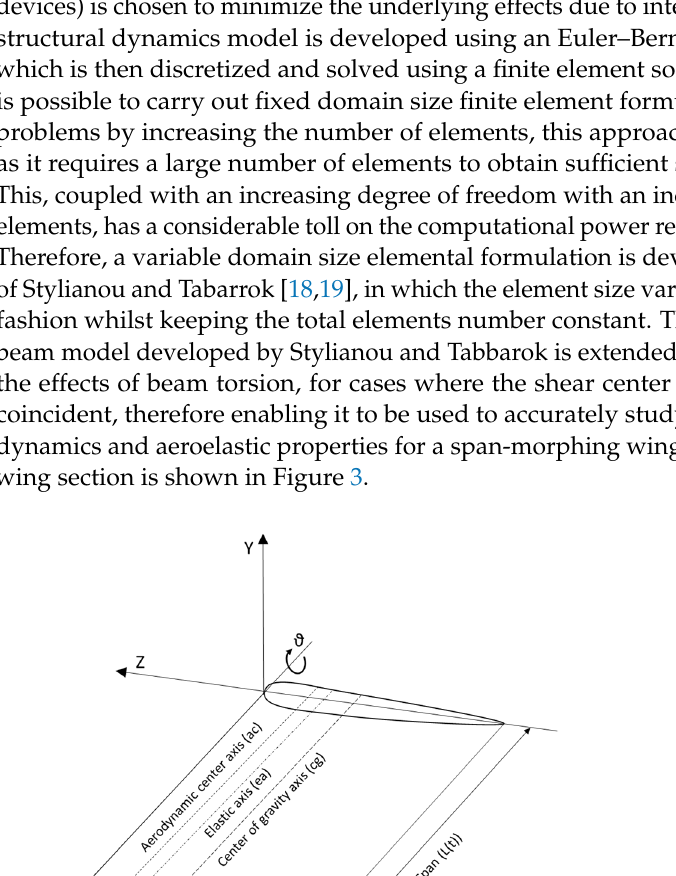
Figure 2. ASAPP wing internal structure ( left ) and actuation mechanism ( right )